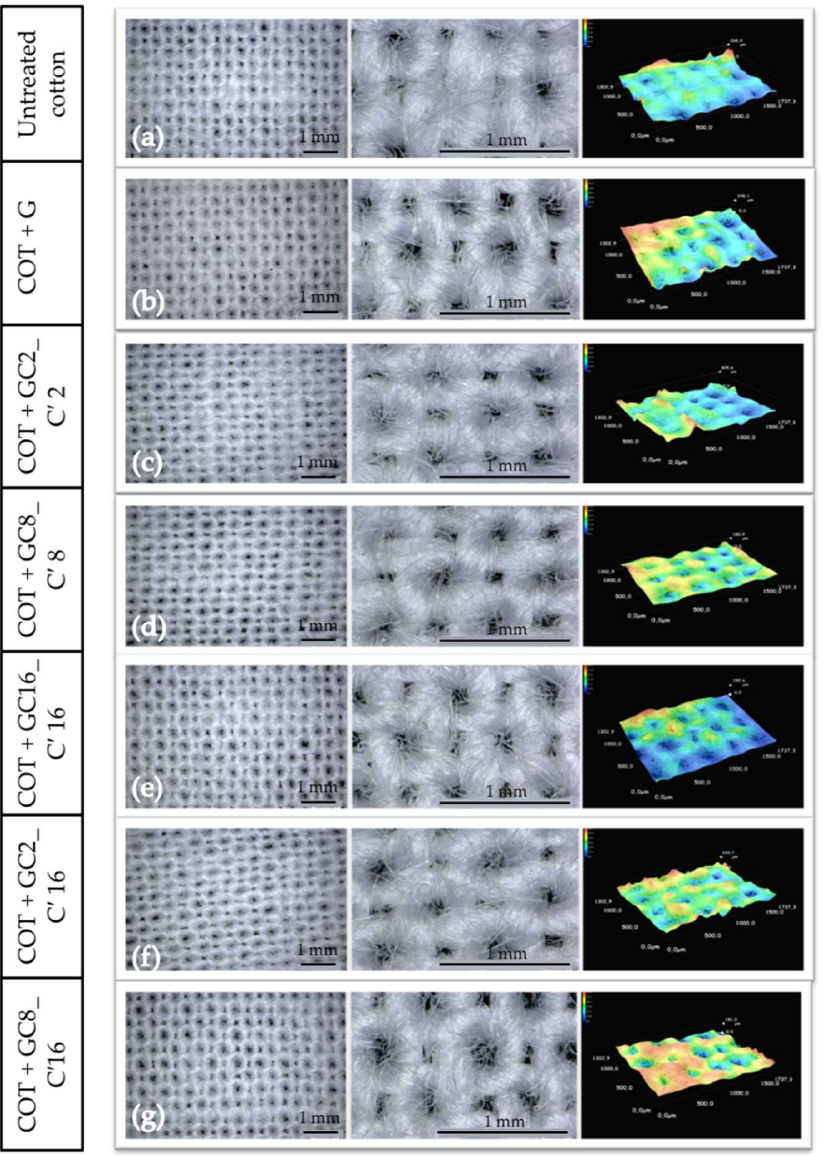
Figure 13. Optical images of untreated ( a ) and treated ( b – g ) cotton fabrics at different magnification and 3D image of the roughness of the analyzed samples.